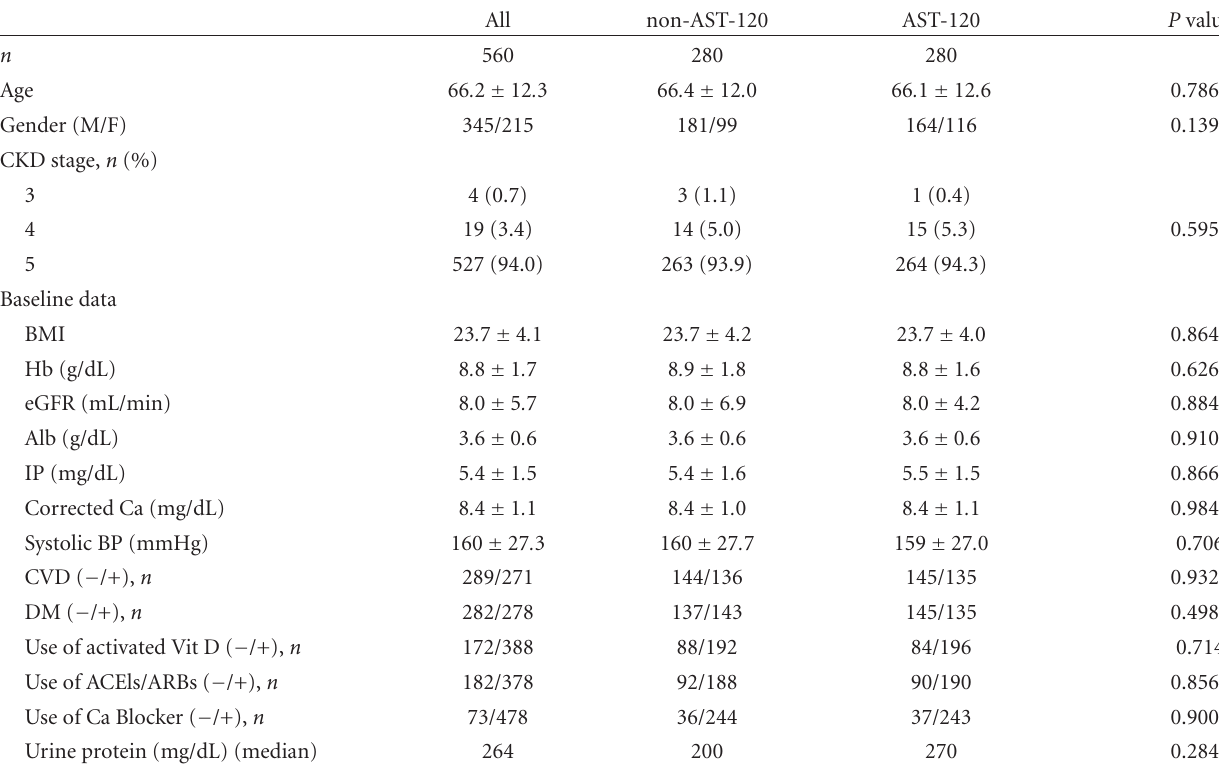
Table 2: Characteristics of 560 pair-matched patients. No significant di ff erences were observed in the backgrounds of the two groups.